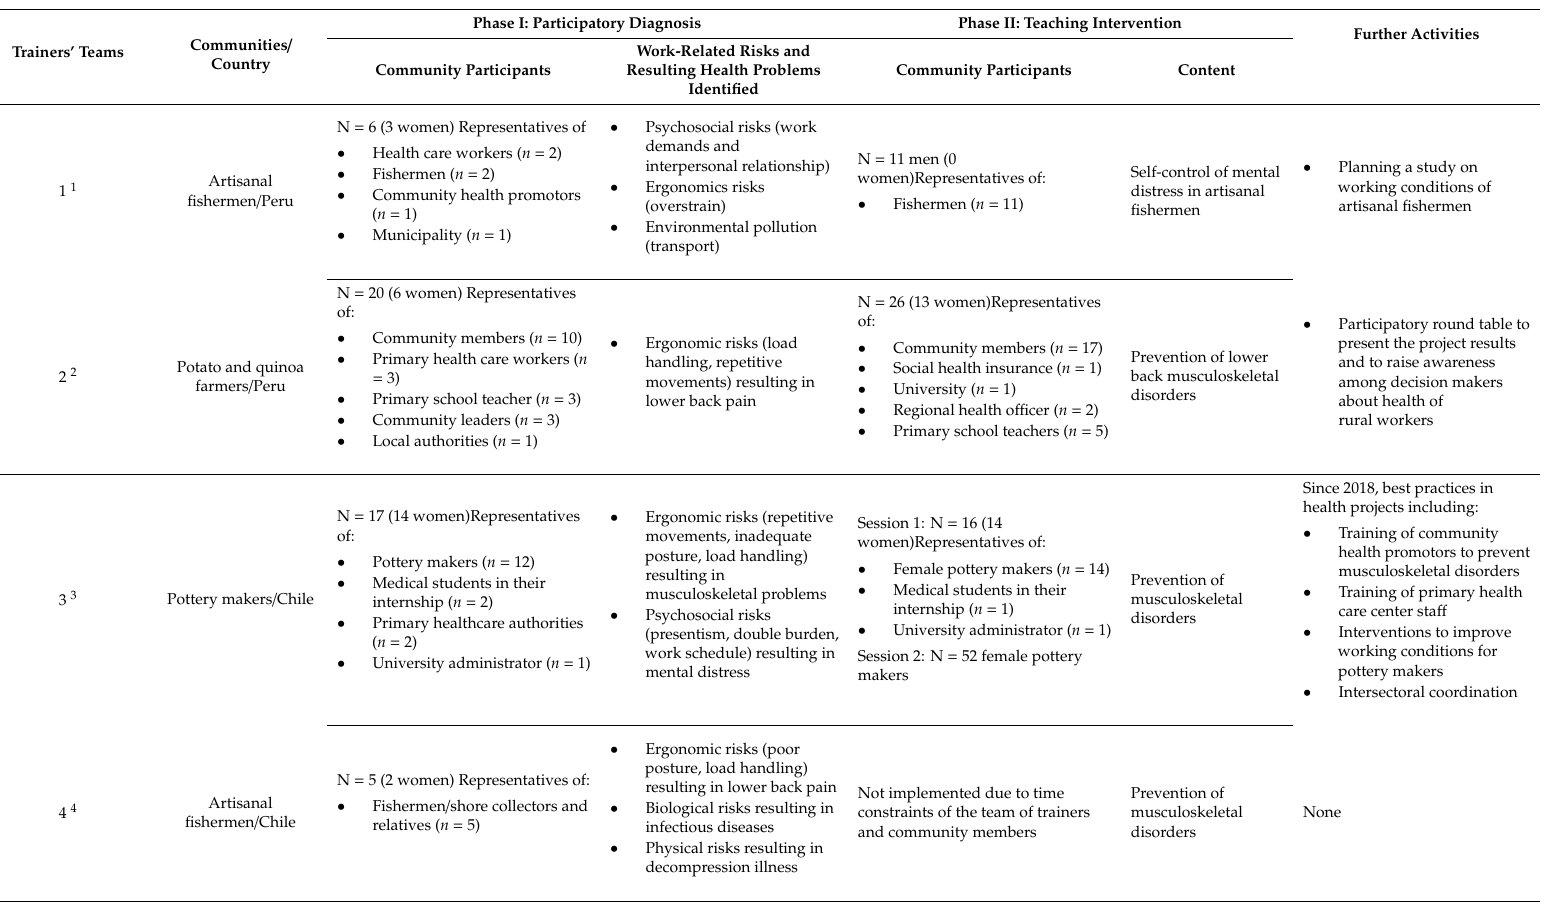
Table 2. Findings from the participatory diagnosis, topics of the teaching interventions, and related activities carried out by the teams of trainers. Trainers’